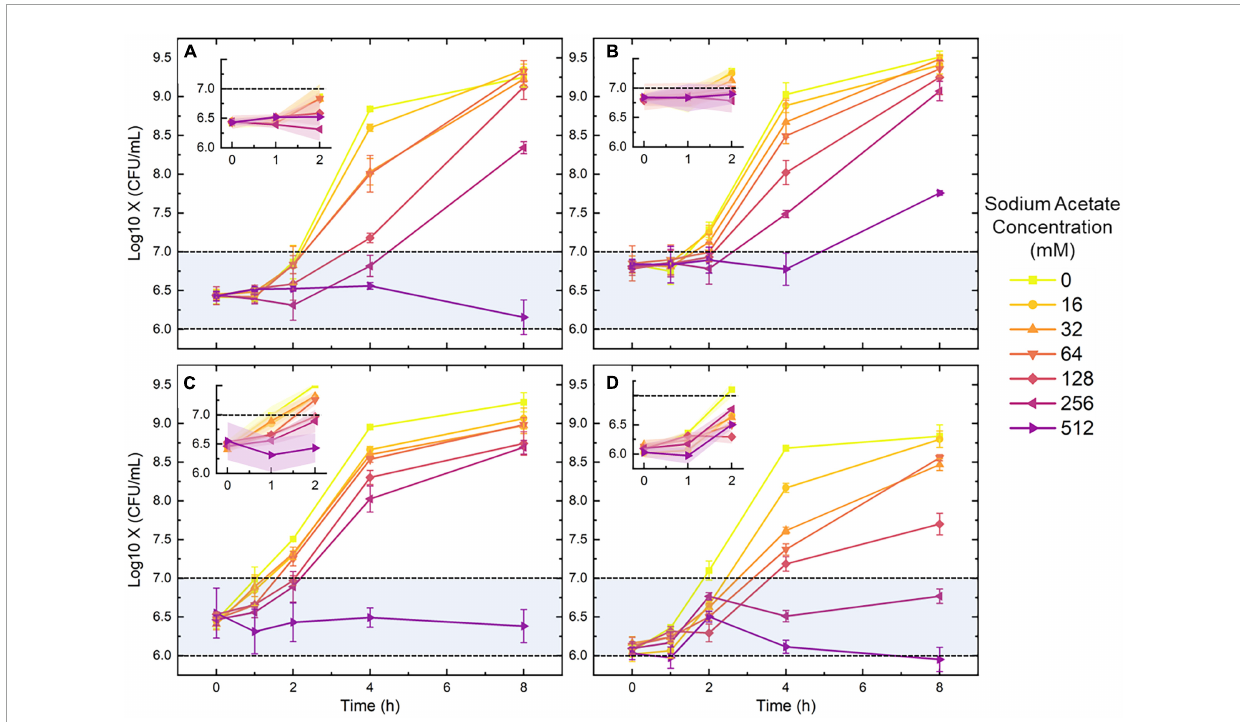
FIGURE1 The growth curves of Escherichia coli (A) , Staphylococcus aureus (B) , Pseudomonas aeruginosa (C) , and Enterococcus faecalis (D) under the pressure of seven sodium acetate (SA) concentrations. The four detailed diagrams displaced in the upper-left corner of panels (A–D) are the 0-2 h growth curves of the four species. Blue regions represent the initial level of bacterial concentration. Error bars and error ribbons represent the standard deviation of five biological replicates. 0-mM SA serves as the negative control.